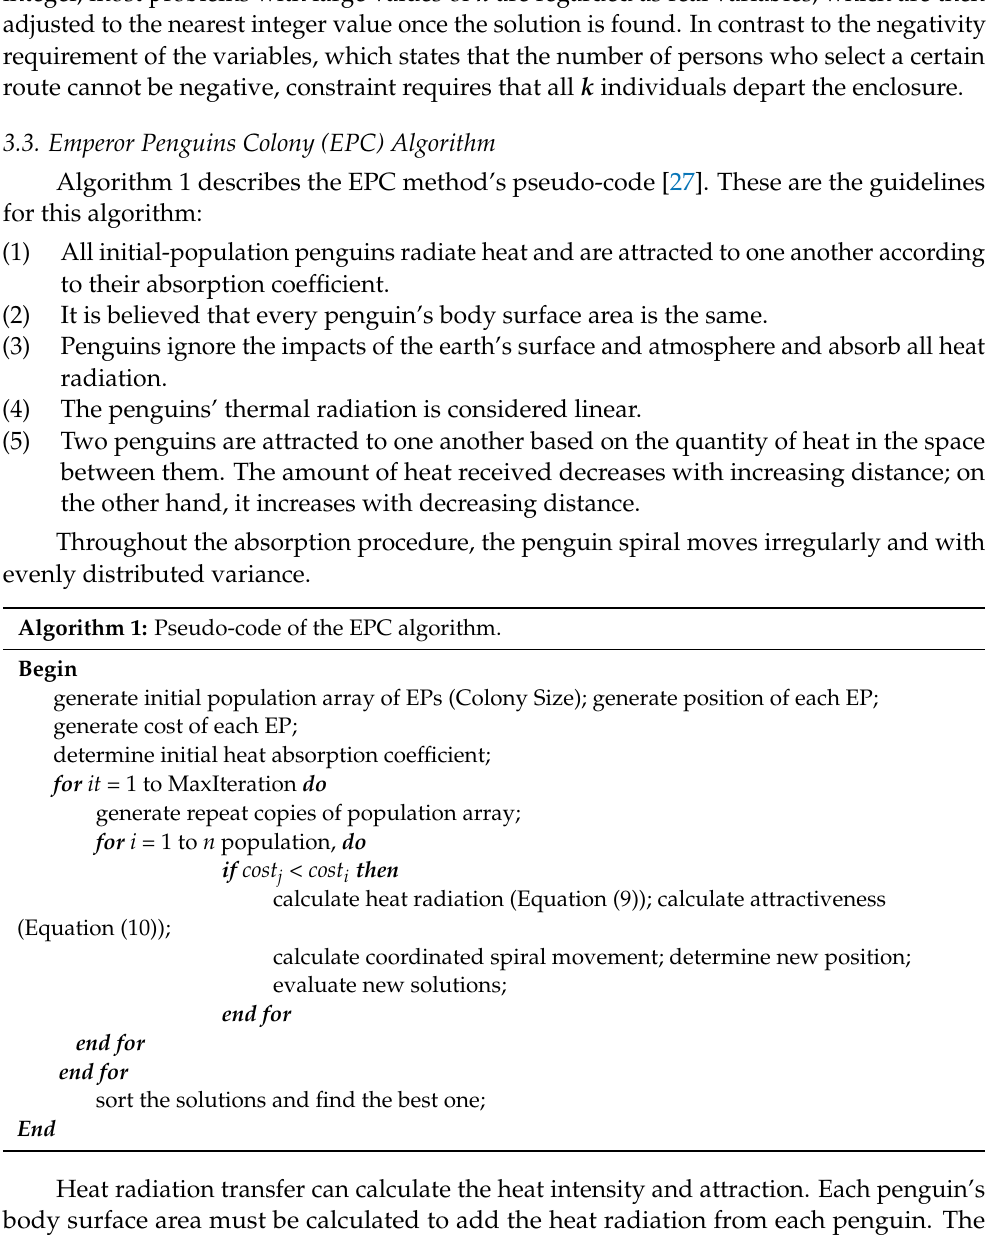
Algorithm 1: Pseudo-code of the EPC